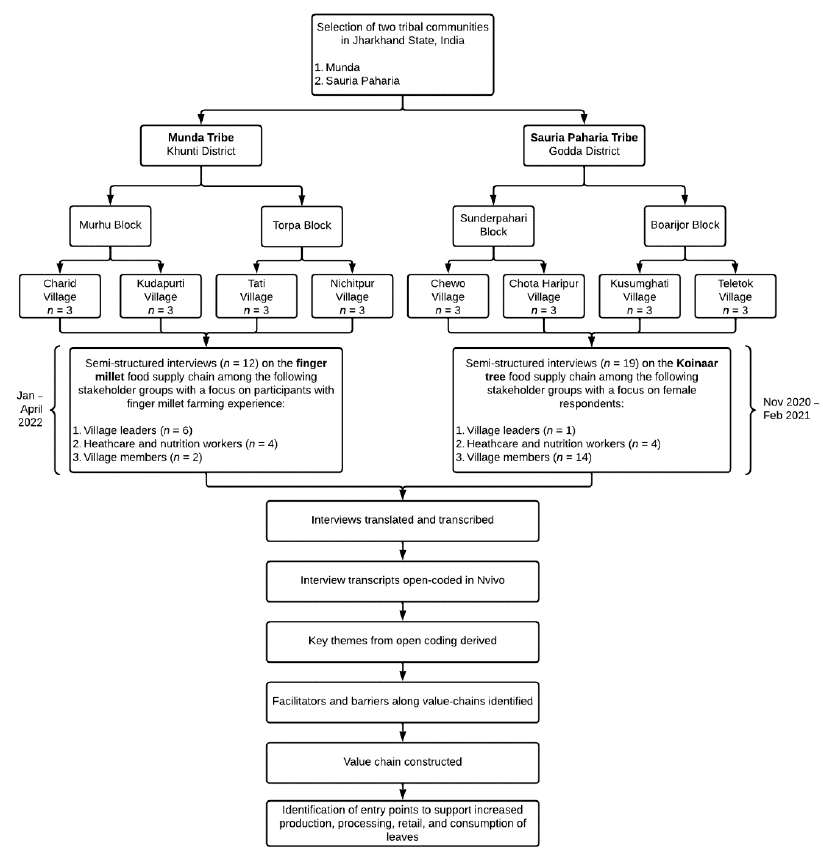
Figure 2. Schematic representation of study .